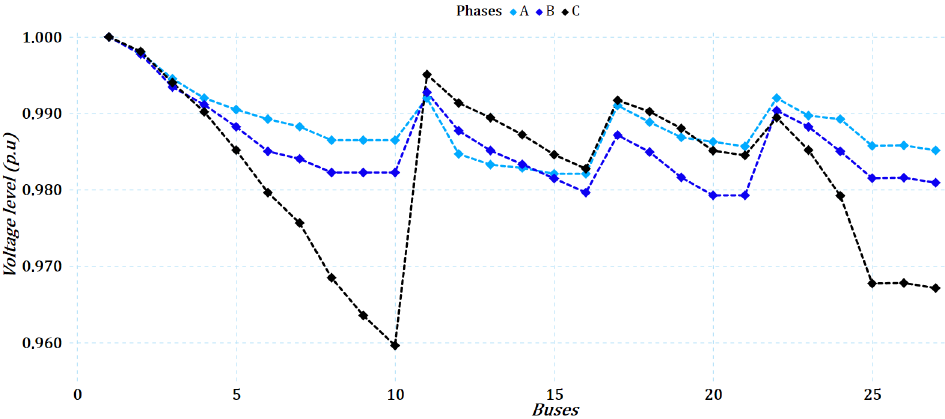
Figure 11. Voltage profiles in the buses for the IEEE 27-bus system